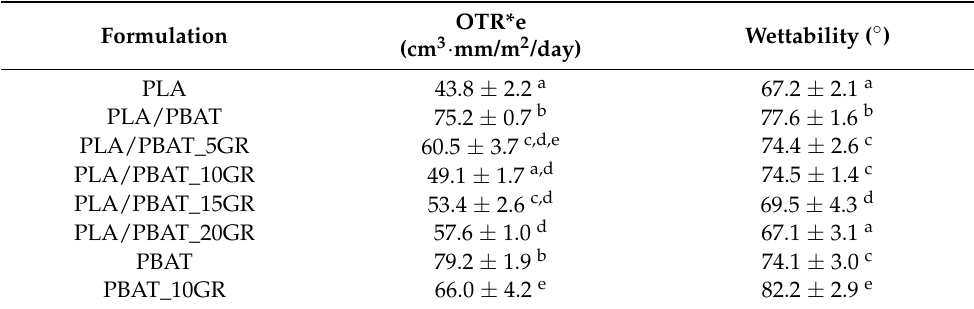
Table 5. Oxygen permeability measurements of PLA, PLA/PBAT, and PLA/PBAT with 5, 10, 15, and 20 phr of GR